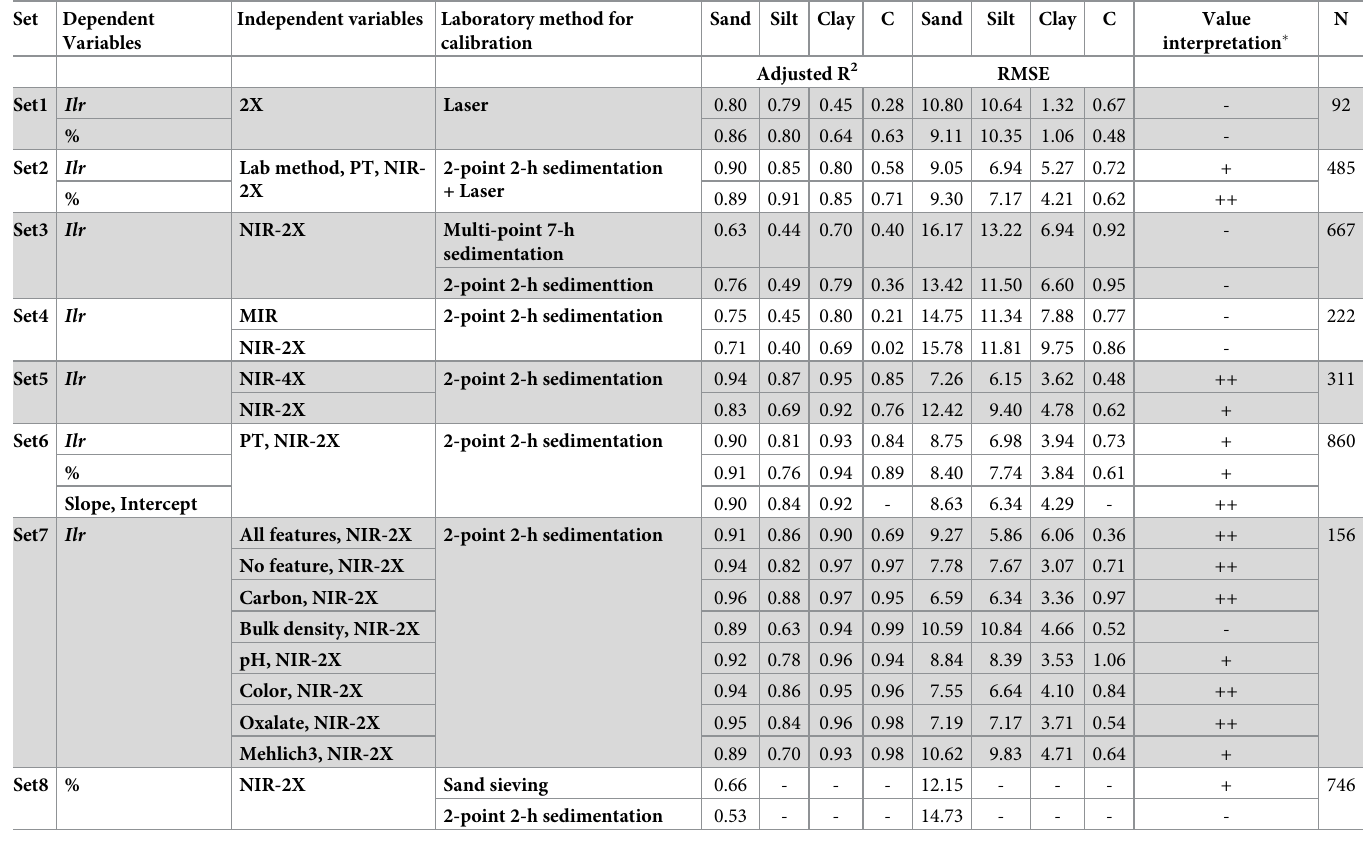
Table 3. Accuracy, slope, intercept, and number of observations of models. Set Dependent